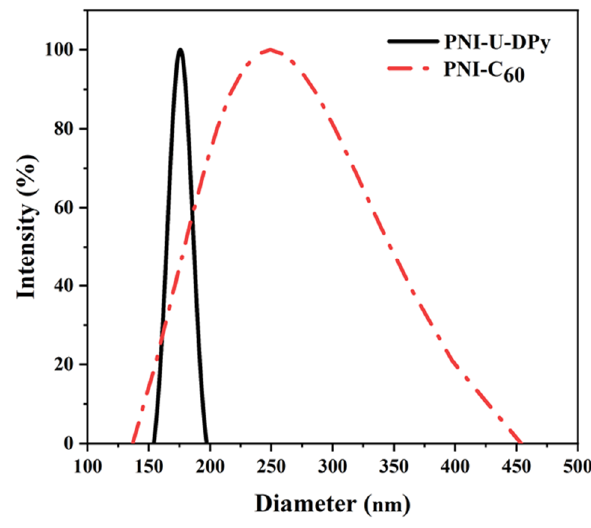
Figure 2. DLS analyses results of PNI-U-DPy micelles and PNI-C 60 micelles.